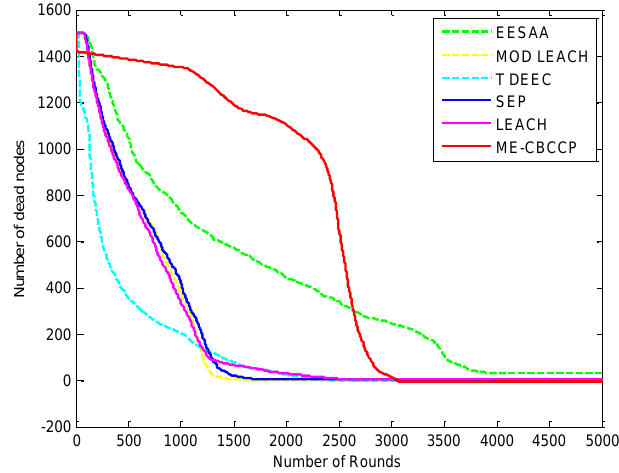
Figure 6. Network lifetime comparison (1500 nodes, with the help of dead nodes in 300 m 2 ).